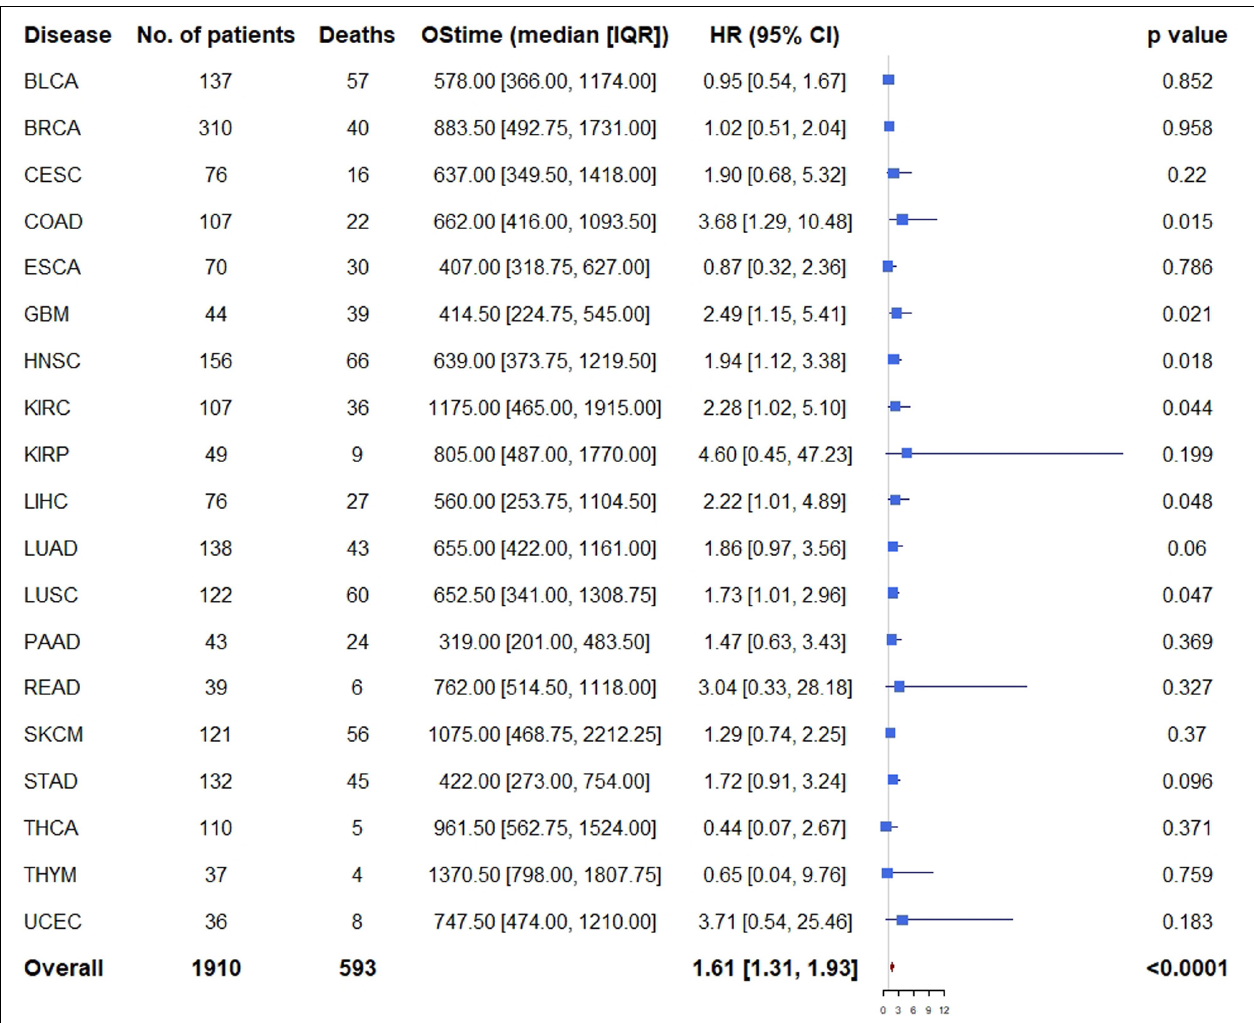
FIGURE 5 | Cox proportional hazards analyses of all the three genes across 20 cancer types. Note: age (young vs. old, the median age as the threshold), sex (male vs. female) and disease stage (stage III-IV vs. stage I-II) were included in the multivariable model for adjustment. p < 0.05 represents significant difference in survival